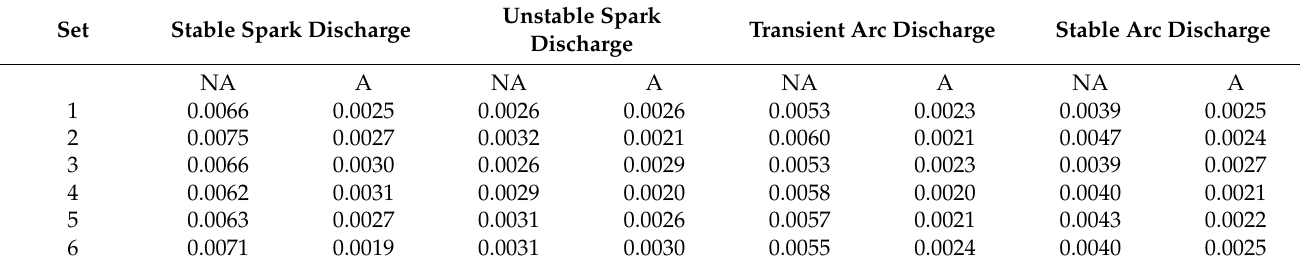
Table 3. Largest Lyapunov exponent of 6 sets of experiment data 1